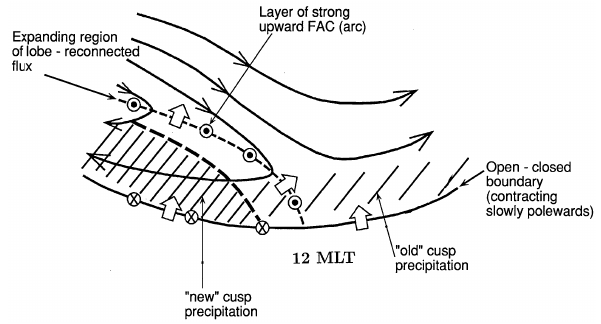
Fig. 8. Schematic of convection and field-aligned current (FAC) geometry in the ∼ 1000–1200 MLT cusp region, illustrating the in- trusion of transient lobe convection cell and the polar arc emanating from the eastern boundary of the new enhanced cusp emission. The latter is marked by the hatched area on the left side of the figure. North is up and west is to the left. The polar arc (upward FAC) is located near the boundary between fast eastward flows in the pole- ward region, driven by the previous interval of southward IMF, and the the much slower flows which have an equatorward component, which is associated with lobe